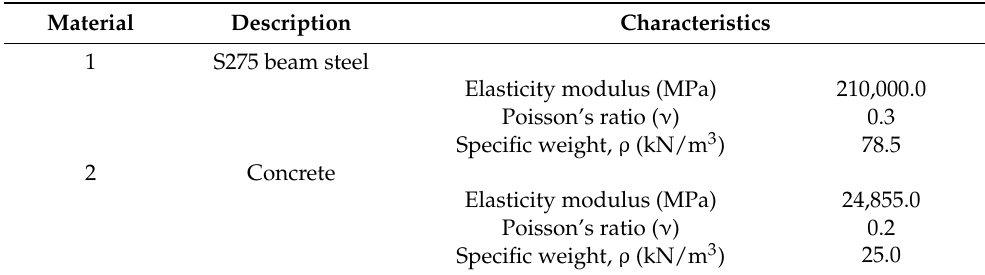
Table 4. Material characteristics of the footbridge.